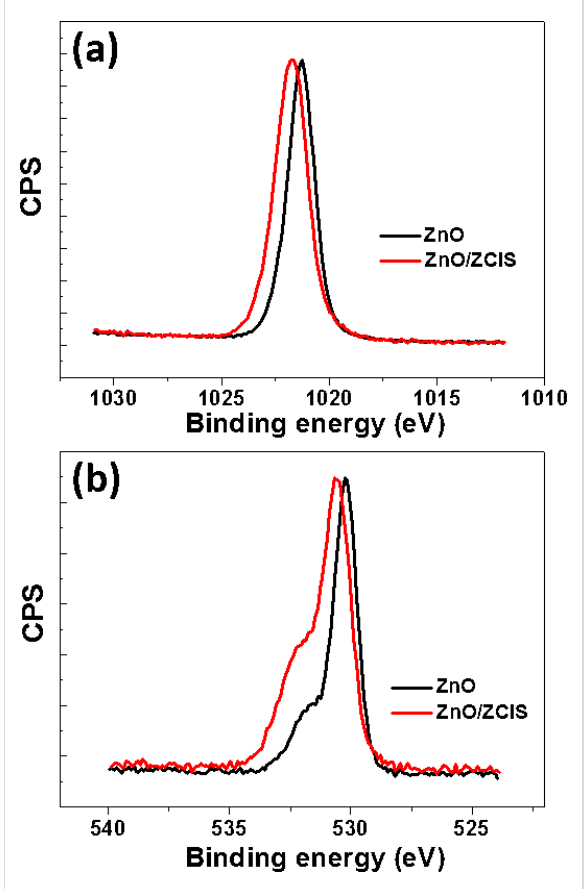
Figure 3: High-resolution XPS spectra of (a) Zn 2p 3/2 and (b) O 1s in ZnO and in the ZnO/ZCIS composite.